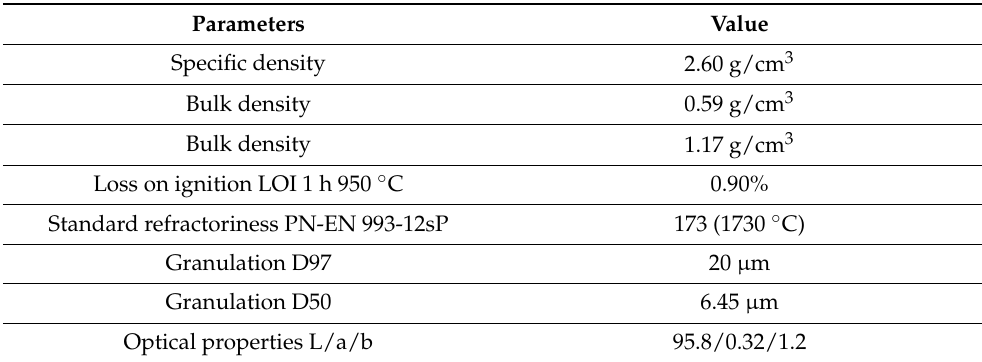
Table 2. Parameters of micronized chalcedonite Crusil M20.